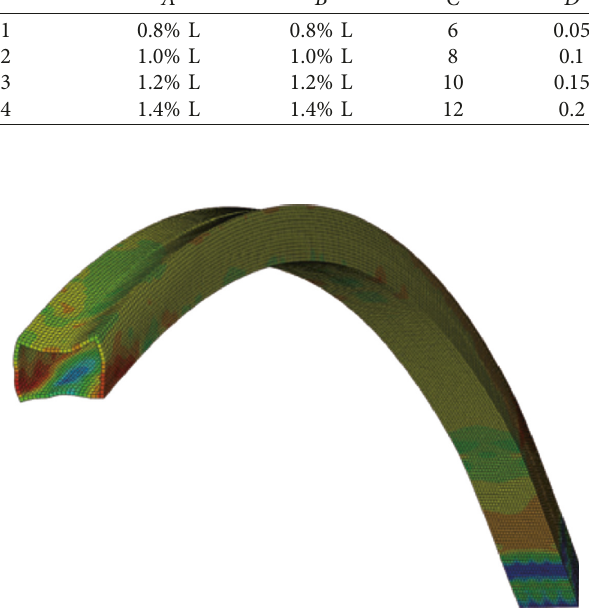
Figure 9: Numerical simulation of the profile deformation.